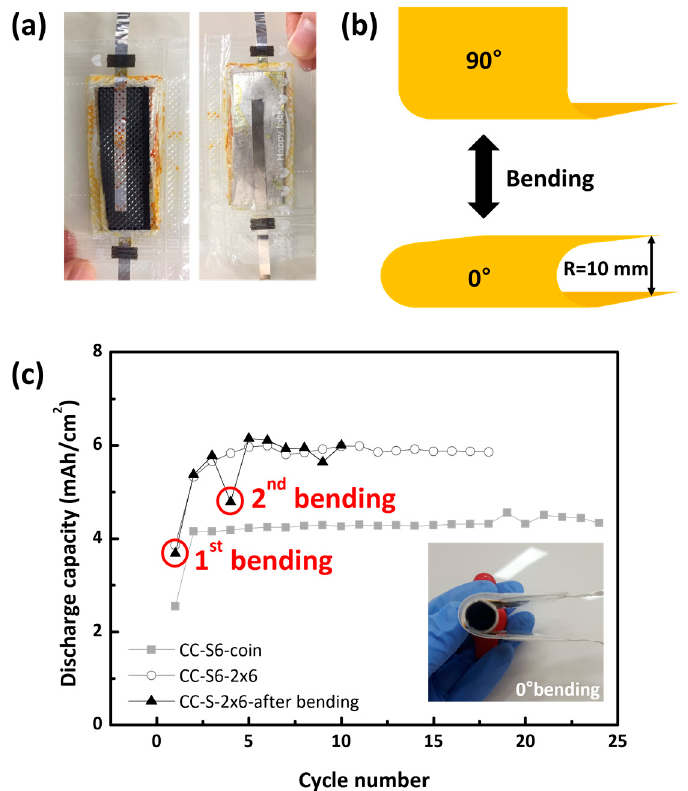
Figure 4. ( a ) Photo images of 2 cm × 6 cm pouch cell showing the CC electrode (left) and the Li metal anode (right); ( b ) Scheme of the pouch cell bending test condition; ( c ) Cycle stability of the pouch and coin cells in the potential range of 1.5–3.0 V vs. Li/Li + at C/10 (inset photo image shows the pouch cell bended at 0 ° ).